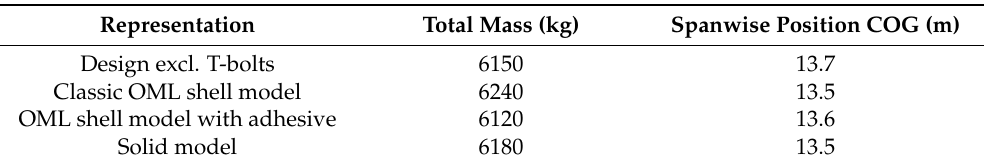
Table 2. Overview of the masses of the different models and design. The T-bolts are not included. COG: center of gravity.